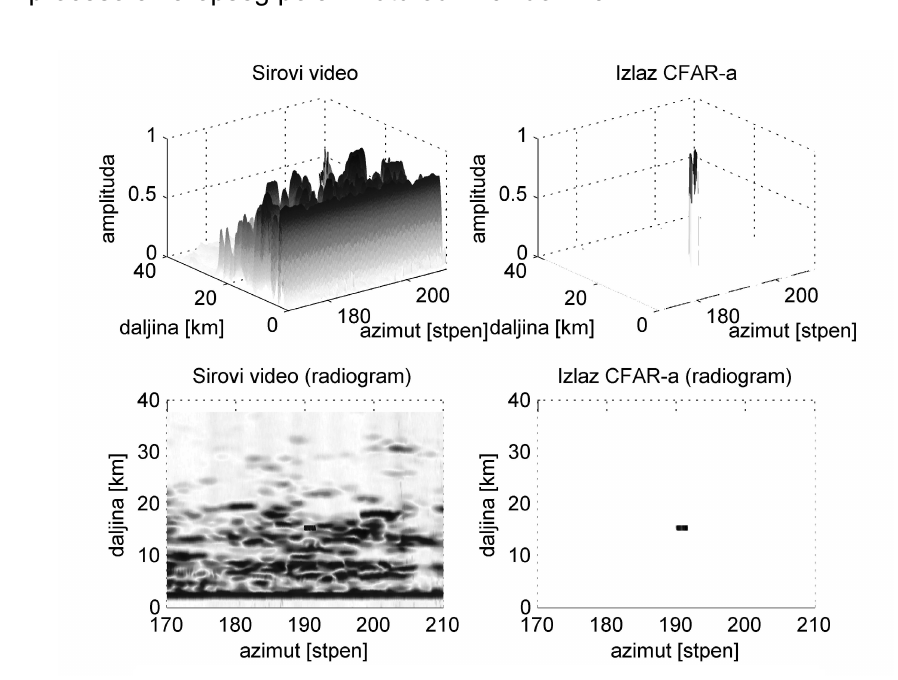
Da bi se proverila ta č nost procene Doplerove frekvencije, u prvom slu č aju je simuliran cilj sa Doplerovom frekvencijom od 1500 Hz. Para- metri cilja prikazani su u tabeli 2. Parametri cilja U Doplerova frekvencija f daljina R azimut θ Parametar amplituda s d Vrednost 2 1500 Hz 15 km 190 ° Na slici 4 prikazan je sirovi video signal i signal na izlazu iz CFAR procesora za opseg po azimutu od 170° do 210°.